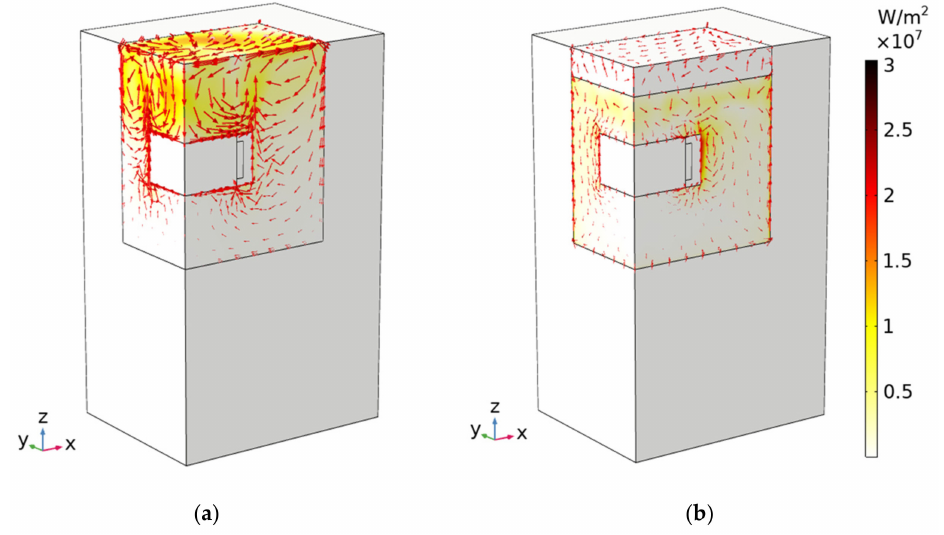
Figure 7. Heat flux distribution and LN2 velocity streamlines at ( a ) t = 0.5 s and ( b ) t = 30 s. Figure 8 relates to the characteristics of the total mass evolution in time. The mass measured using the digital scale is shown as (a), the data obtained through 3D FEA are (b), and those by the exponential fitting of experimental measurements are shown as (c). Figure 9 shows the characteristics of the evolution of thermal power released from the YBCO bulk in time. Characteristic (a) was obtained by discrete analysis of the total mass evolution measured, as shown in characteristic (a) of Figure 8. This discrete analysis consisted of transforming Equation (27) by Equation (29),